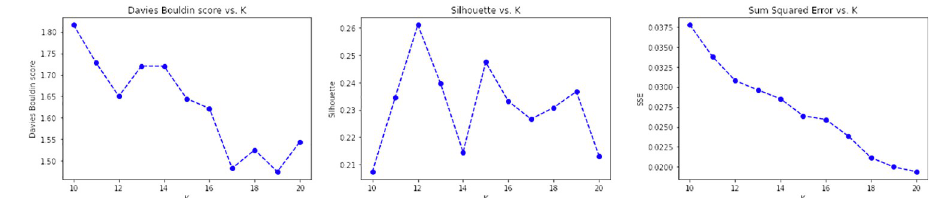
Fig 19. Validation results obtained for